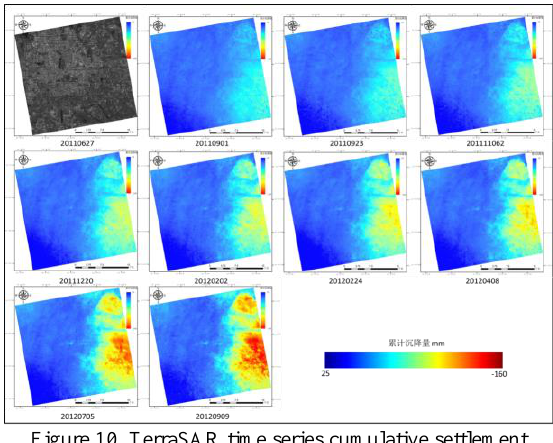
Figure 10. TerraSAR time series cumulative settlement 2.3 The land subsidence monitoring result Taking the two cumulative settlement graphs which were generated by different image resolution and different time series data to superimposed under the same geographical coordinates.